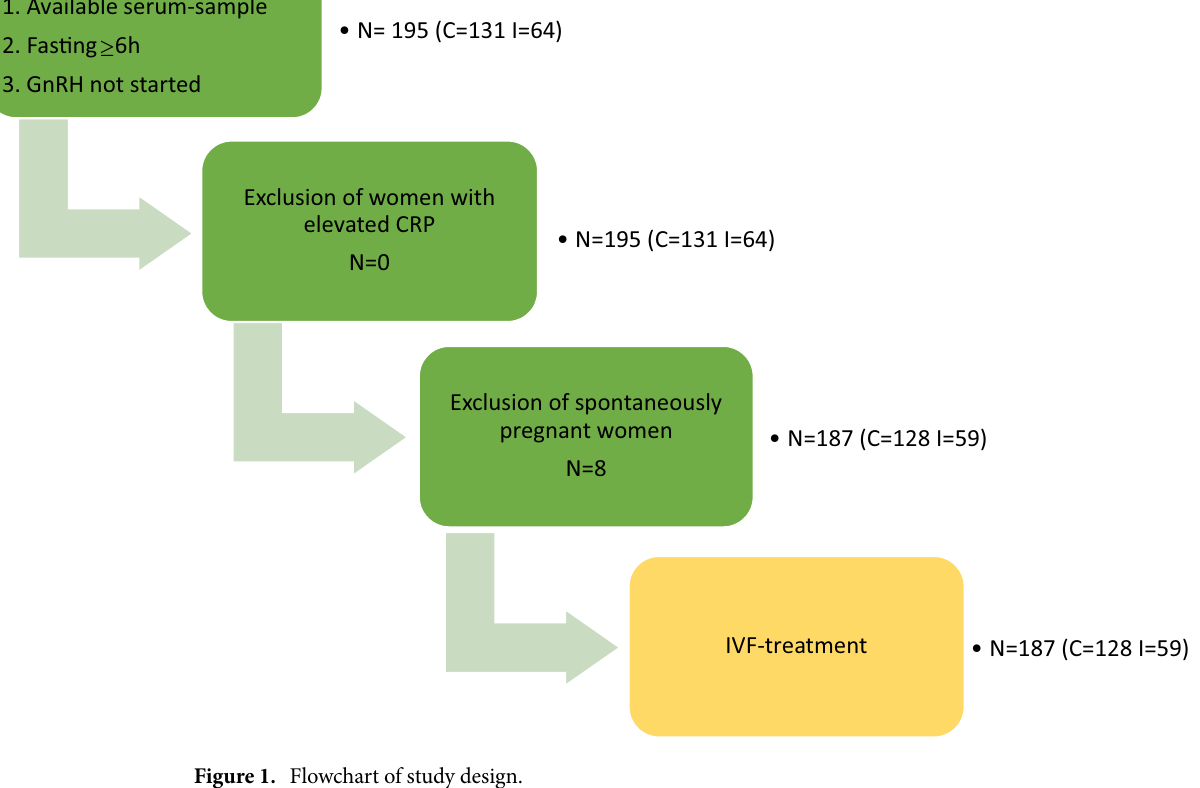
Figure 1. Flowchart of study